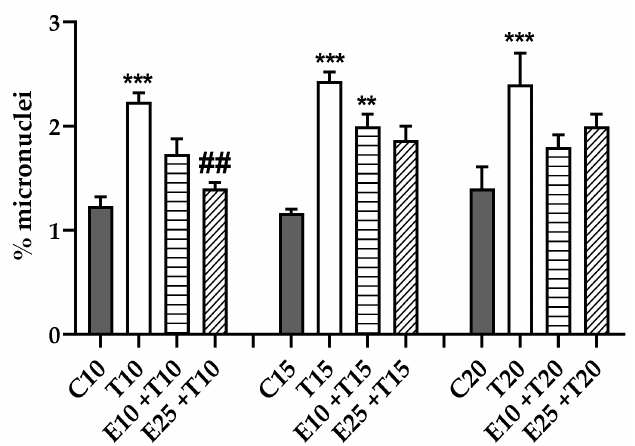
Figure 6. E ff ect of mERC and UV-A radiation on chromosome mis-segregation, measured as micronuclei percentage, detected by immunofluorescence. HMEC-1 cells were treated for 1 h with mERC (10 or 25 µ g / mL, E10 and E25) and exposed to 10, 15, 20 J / cm 2 UV-A (T10, T15, T20). Results are expressed as mean ± SEM, n = 3. Statistical analysis: One-Way ANOVA with Bonferroni’s post hoc analysis. ** p < 0.01, *** p < 0.001 vs. C PBS, ## p < 0.01 vs.